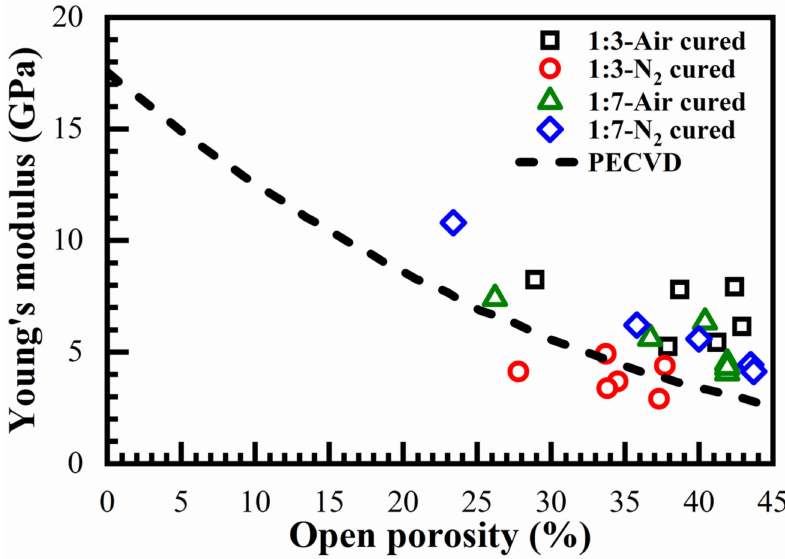
Figure 14. Dependence of Young’s modulus on porosity and benzene bridge ratios (1:3 and 1:7) for films cured in the air (air-cured) and in N 2 (N 2 -cured). The short dash line corresponds to the change of Young’s modulus calculated for plasma enhanced-chemical vapor deposition (PECVD)